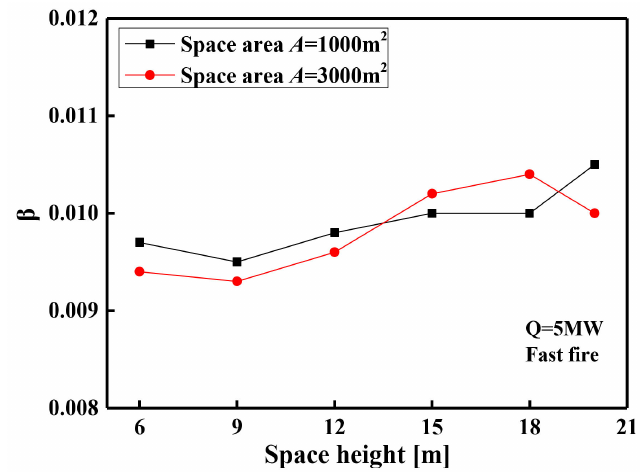
Figure 16. The β value changes with the space heights under different space areas.